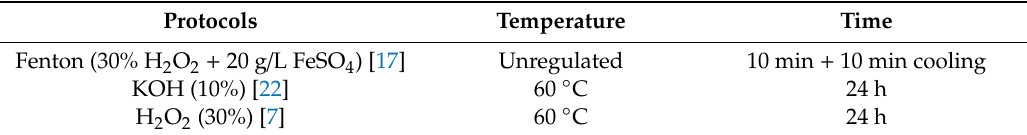
Table 1. Protocols investigated in this